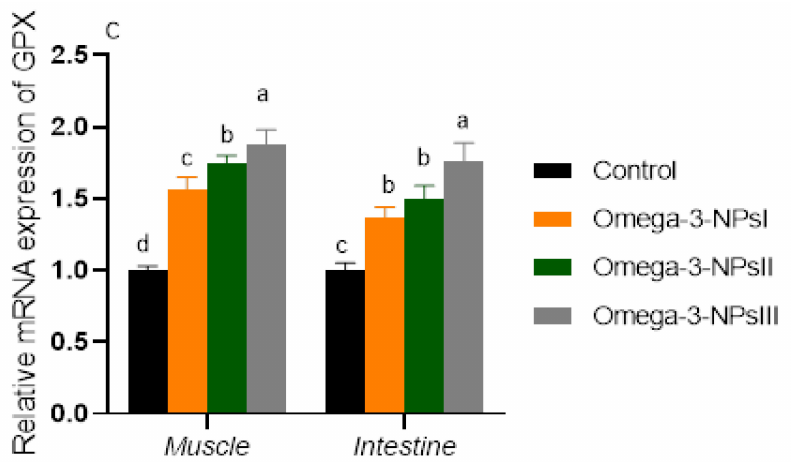
Figure 2. Effect of diets enriched with different supplemental levels of omega-3NPs (omega-3 nano particles) on real-time PCR analysis of oxidative-related genes [ SOD ( a ), CAT ( b ), and (GPX ( c )] expression in the muscle and intestine of Nile tilapia before challenge with Aeromonas hydrophila . Data are expressed as means ± SE. Bars with different letters denote significant differences ( p < 0.05). Control: basal diet without omega-3-NPs omega-3-NPs I, II, and III: basal diet supplemented with omega-3-NPs at levels of 1, 2, and 3 mg/kg diet, respectively.